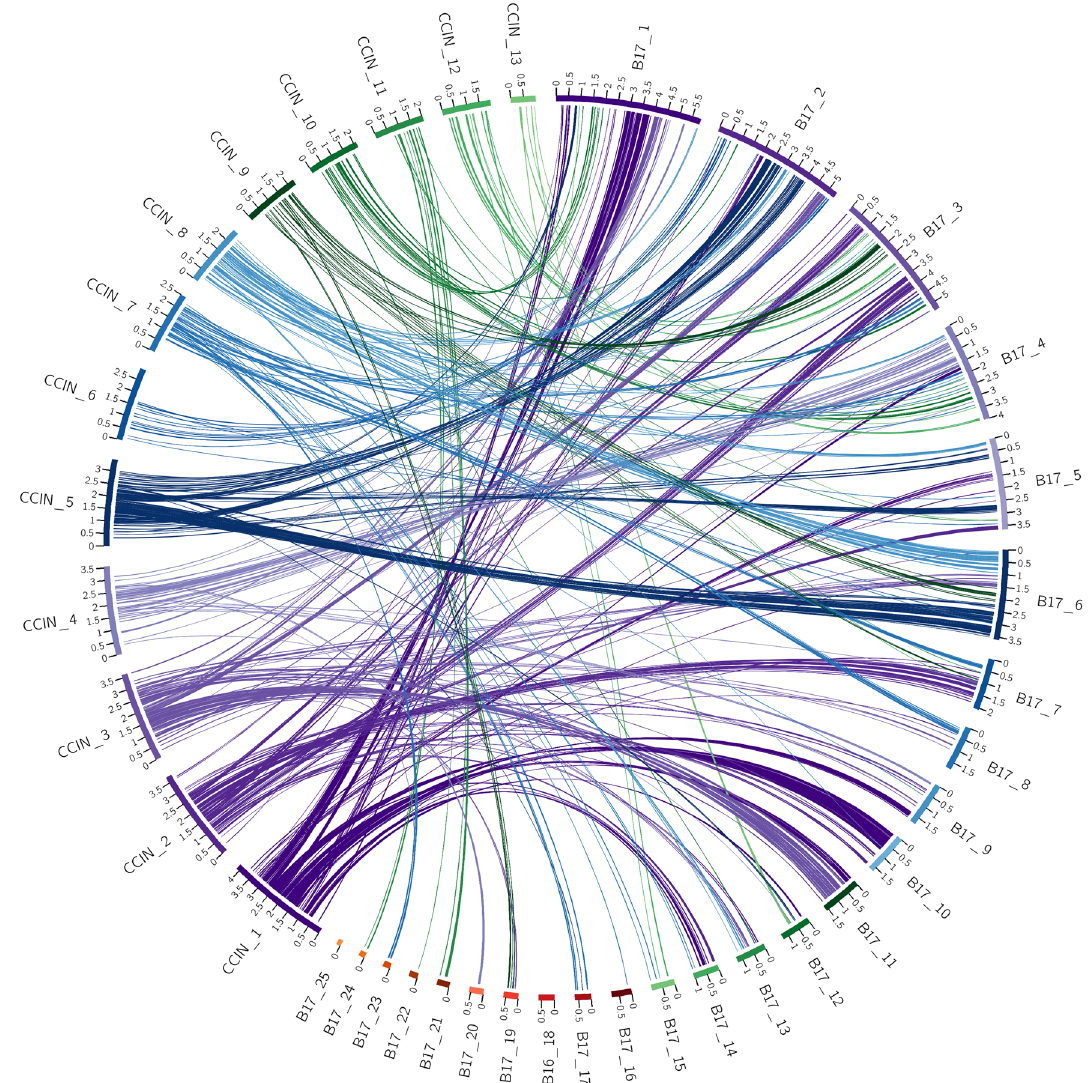
Figure 2. Circos plot of shared syntenic regions between C. cinerea and L. edodes B17. Syntenic regions are connected with colored ribbons scaled to the size of the syntenic regions. These ribbons match the colors of the C. cinerea scaffold blocks. Genomic scaffold lengths are in Mb and are indicated by the numerals on each